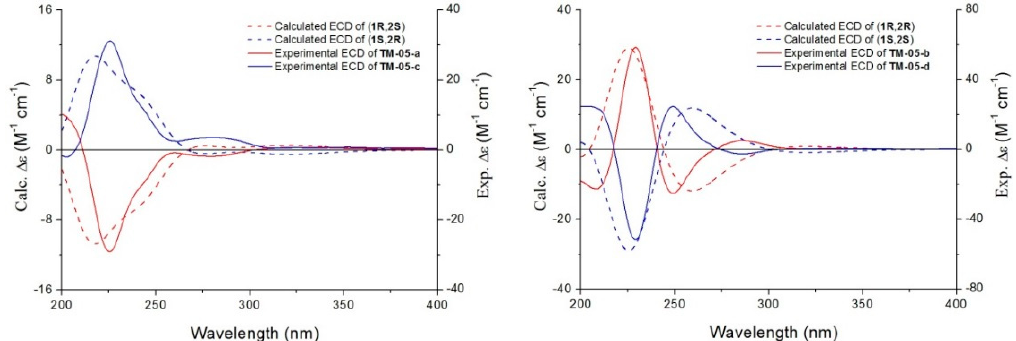
Figure 2. Comparison of experimental ECD spectra and calculated ECD spectra of the four TM-05 optical isomers.